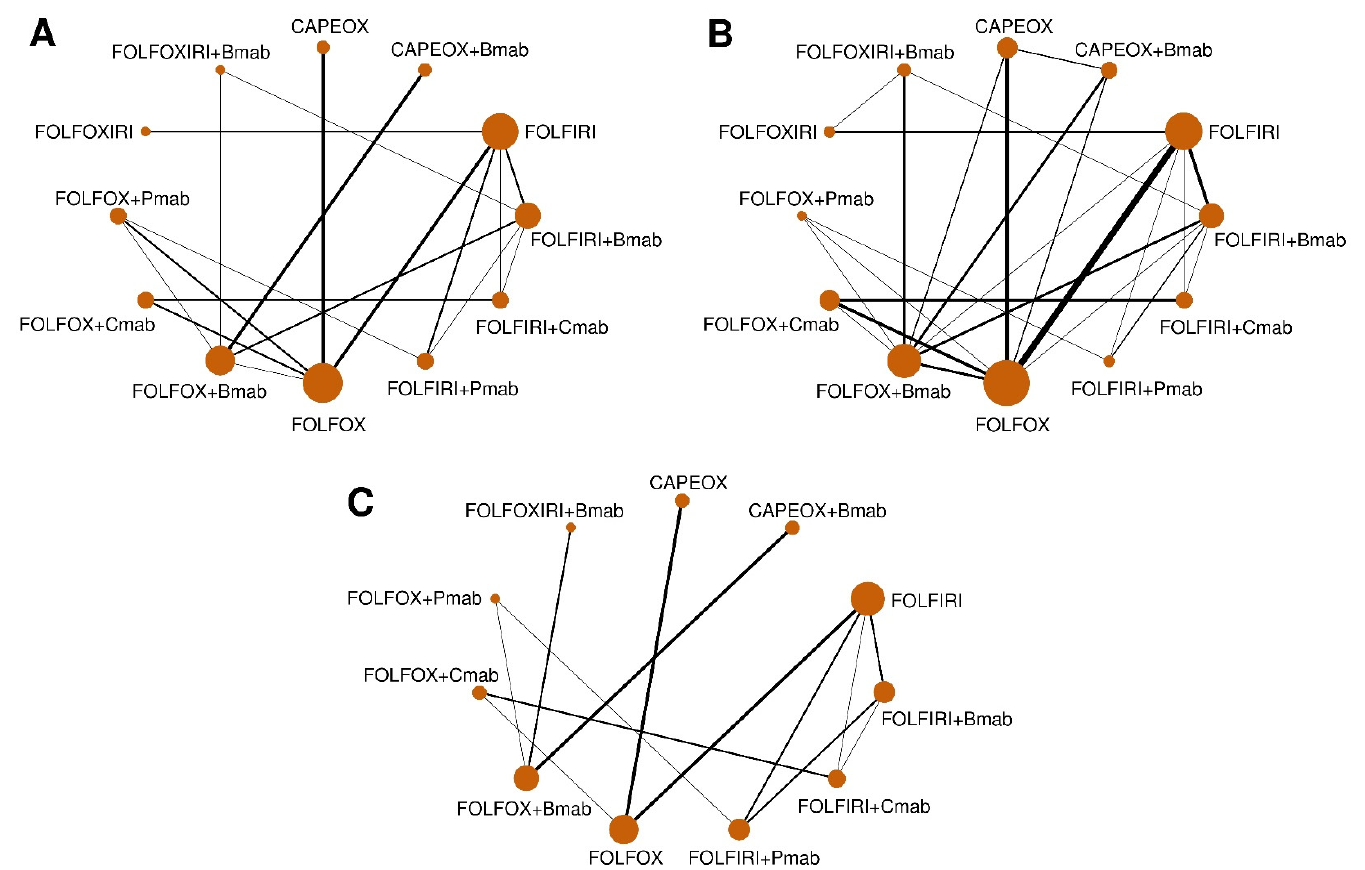
Figure 1. Network geometry of head-to-head trials. Data are presented as networks for comparison of ( A ) overall survival (observed values only), ( B ) overall survival (combining observed and predicted values), and ( C ) adverse events grade ≥ 3. The width of each line reflects the number of studies. The sizes of the circles are proportional to the number of study participants. FOLFOX (5-fluorouracil, folinic acid, and oxaliplatin), FOLFIRI (5-fluorouracil, folinic acid, and irinotecan), FOLFOXIRI (5-fluorouracil, folinic acid, oxaliplatin, and irinotecan), CAPEOX (capecitabine and oxaliplatin), Bmab (bevacizumab), Cmab (cetuximab), and Pmab (panitumumab).